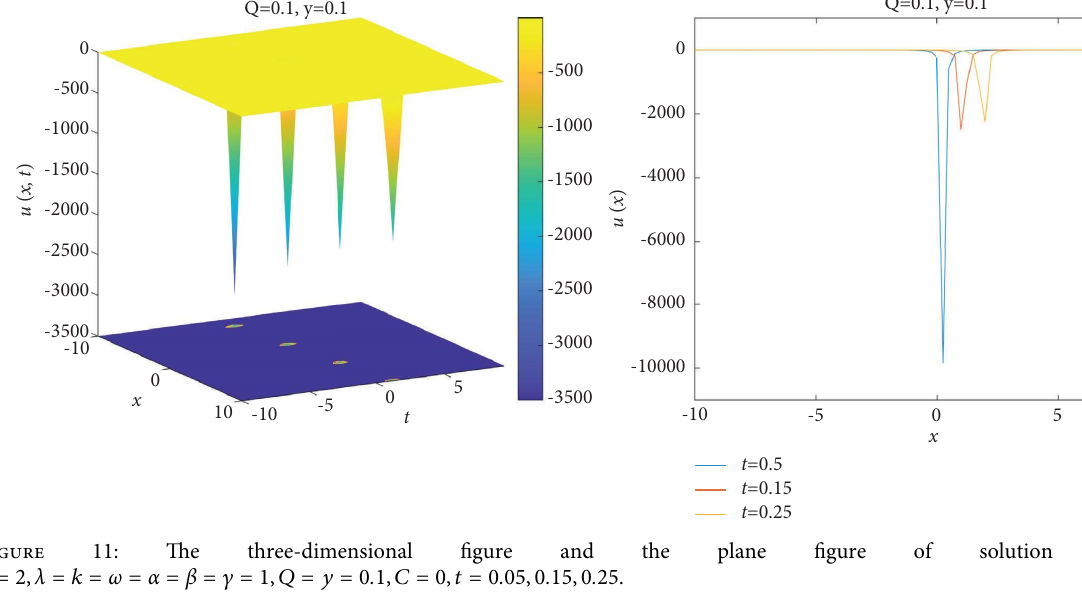
11: Te three-dimensional fgure and the plane fgure of solution (15)